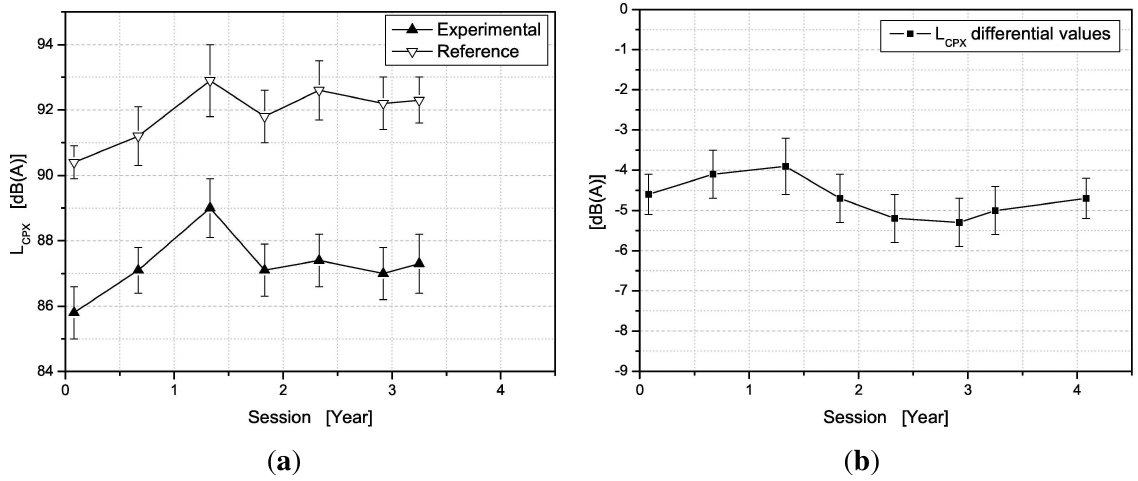
Figure 9. Absolute ( a ) and differential ( b ) values of L